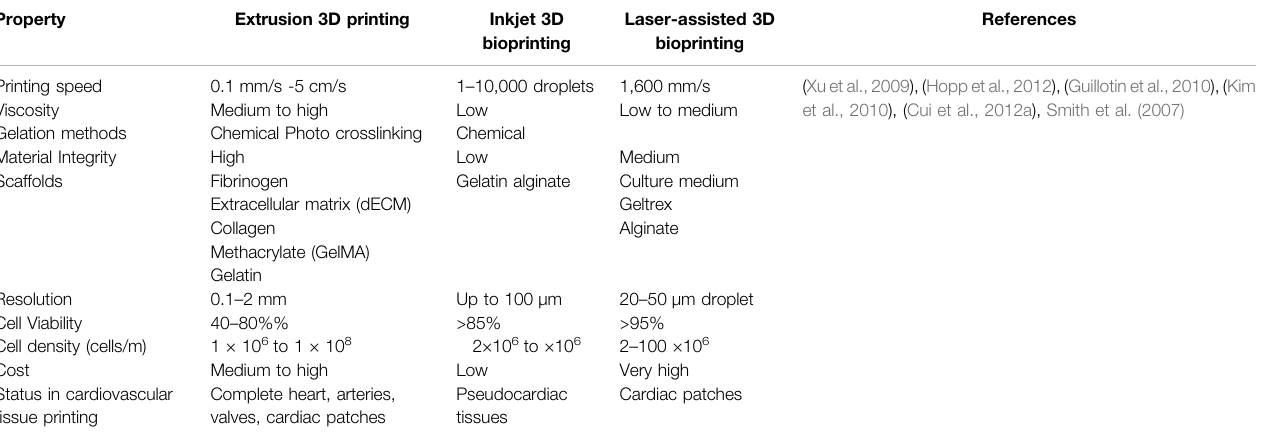
TABLE 1 | Comparison Between different scaffold-based 3D printing techniques for cardiovascular applications.